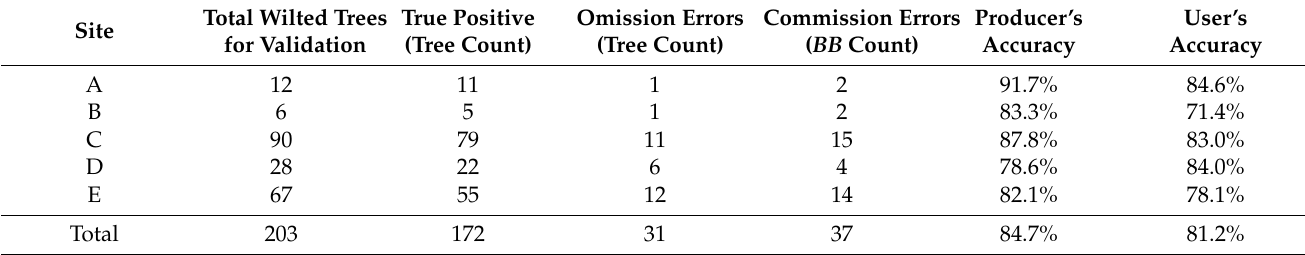
Table 3. Validation results for PWD detection based on the spatiotemporal change detection method. Total Wilted Site